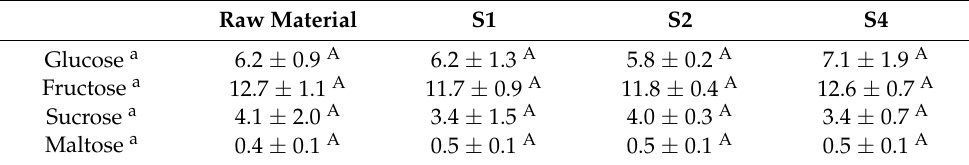
Table A2. Contents of free mono- and disaccharides (g/100 g dm, mean value ± standard deviation, n = 3) of enzymatically treated apple pomace (raw and extruded). S1: only transport elements, S2: two reverse elements, S4: two reverse elements and a kneading block.